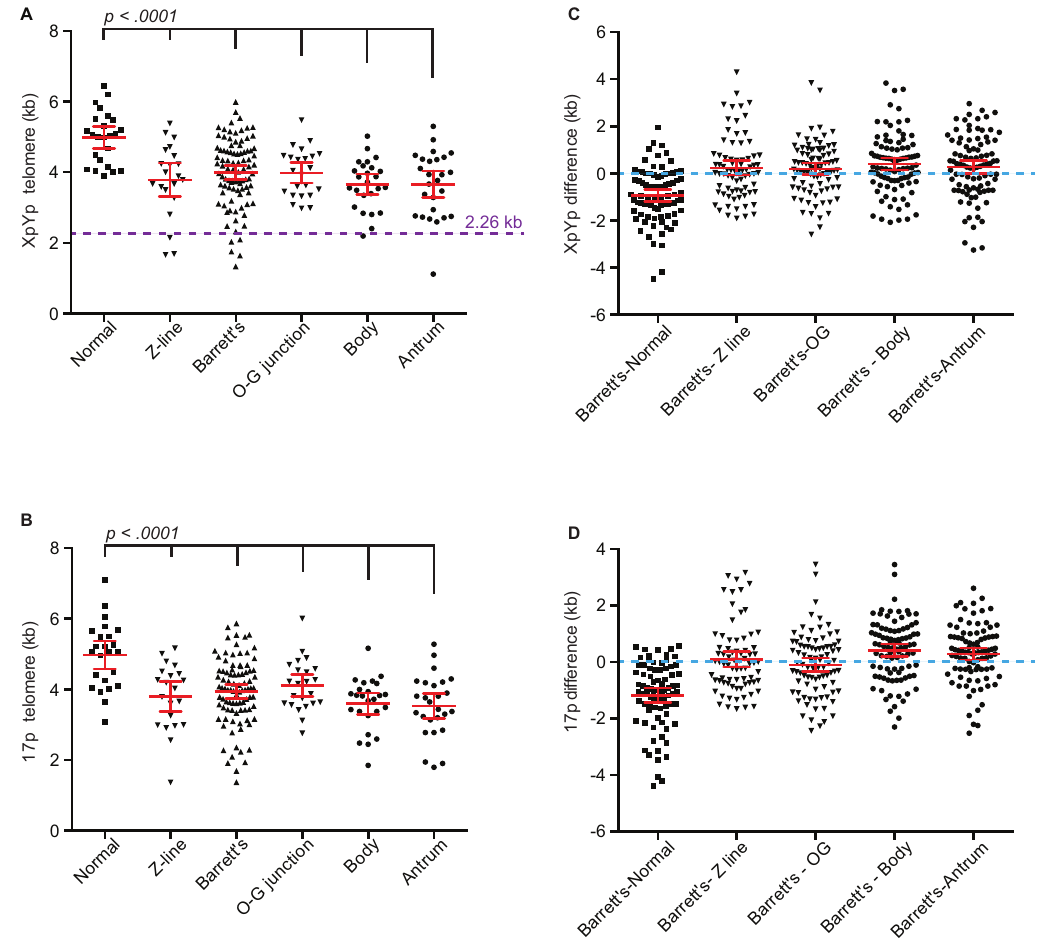
Fig 3. Extensive telomere erosion in Barrett’s metaplasia is similar to that observed in normal gastric tissues. A, mean telomerelengths at the XpYp telomerefrom the tissues indicatedbelow. The purpledashedline represents the 2.2b kb threshold for prognosisdefinedin other tumour types [25]. B, mean telomerelengths at the 17p telomere from the tissues indicatedbelow. C-D, scatter plot displayingthe difference betweenBarrett’s metaplasia samplesand patient matched normal tissues as indicatedat the XpYp telomere (C) and the 17p telomere